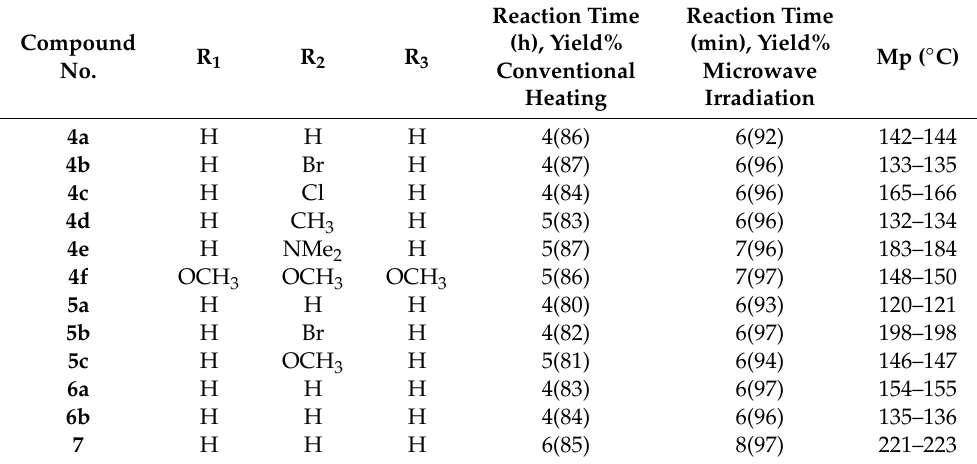
Table 3. Yield (%), reaction time (h, min), and mp ( ◦ C) of 3-substituted-2,3-dihydroquinazolin-4(1 H )- one